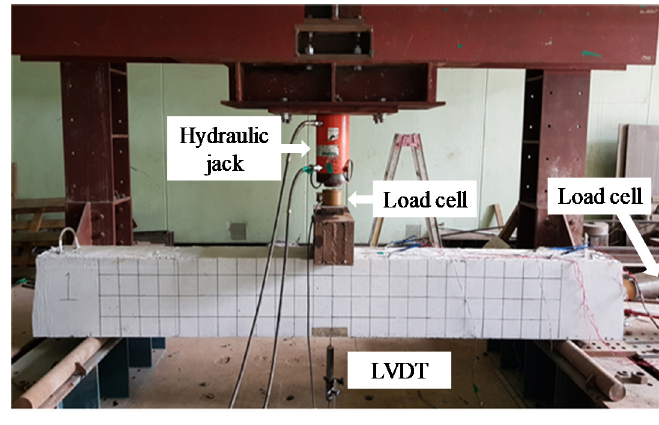
Figure 4. Test setup.